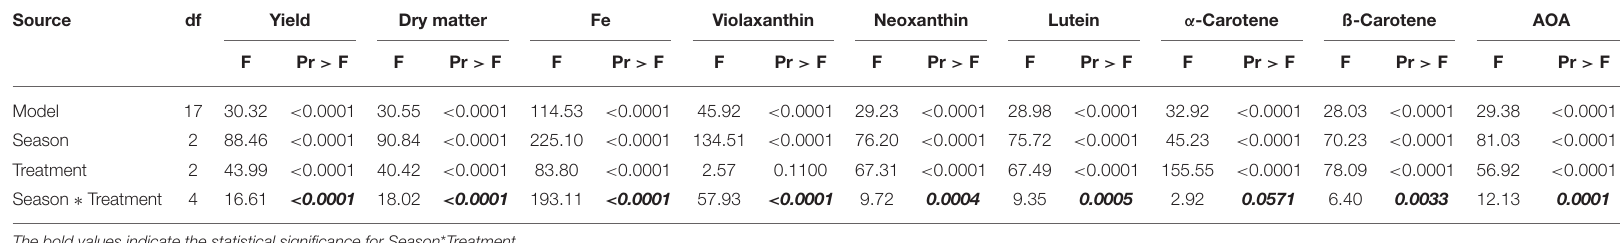
TABLE 1 | Analyses for marketable yield and nutritional content of white amaranth under colored poly-net house, white poly-net house, and open field conditions in Taiwan during 2020- − 2021. Source